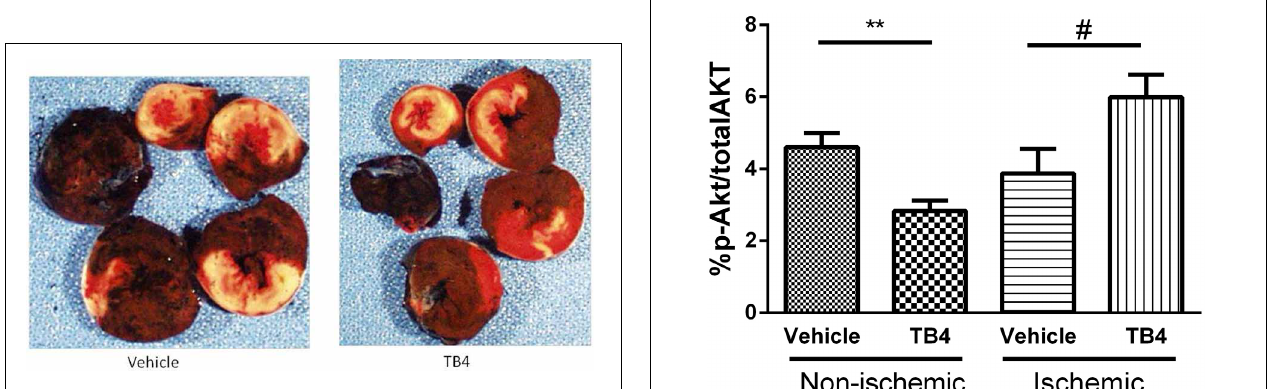
FIGURE 8 | Activation of the Akt pathway by acute administration of IP T β 4 in the rat ischemia-reperfusion model was significant but modest, from 4 to 6% in post-ischemic tissues. Akt activation was reduced in non-ischemic remote myocardial tissue from the same hearts. ∗∗ P < 0 . 01 Vehicle (non-ischemic) vs. T β 4 treated (non-ischemic); # P < 0 . 05 Vehicle (ischemic) vs. T β 4 treated